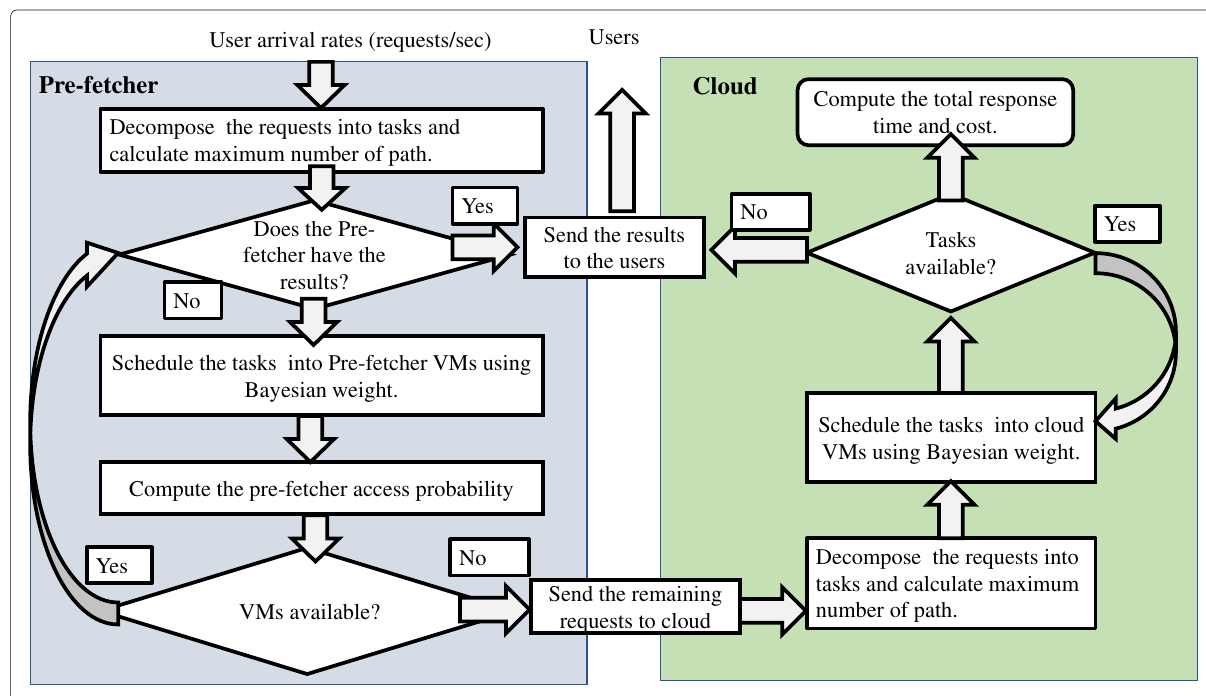
Fig. 2 Heuristic approach of workload scheduling between cloud and end users in the presence of pre-fetcher